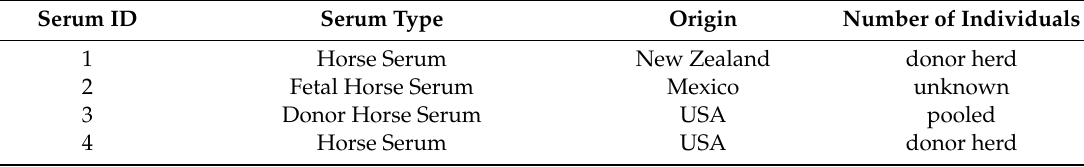
Table 2. General information about the serum samples regarding serum type, land of origin, and the number of